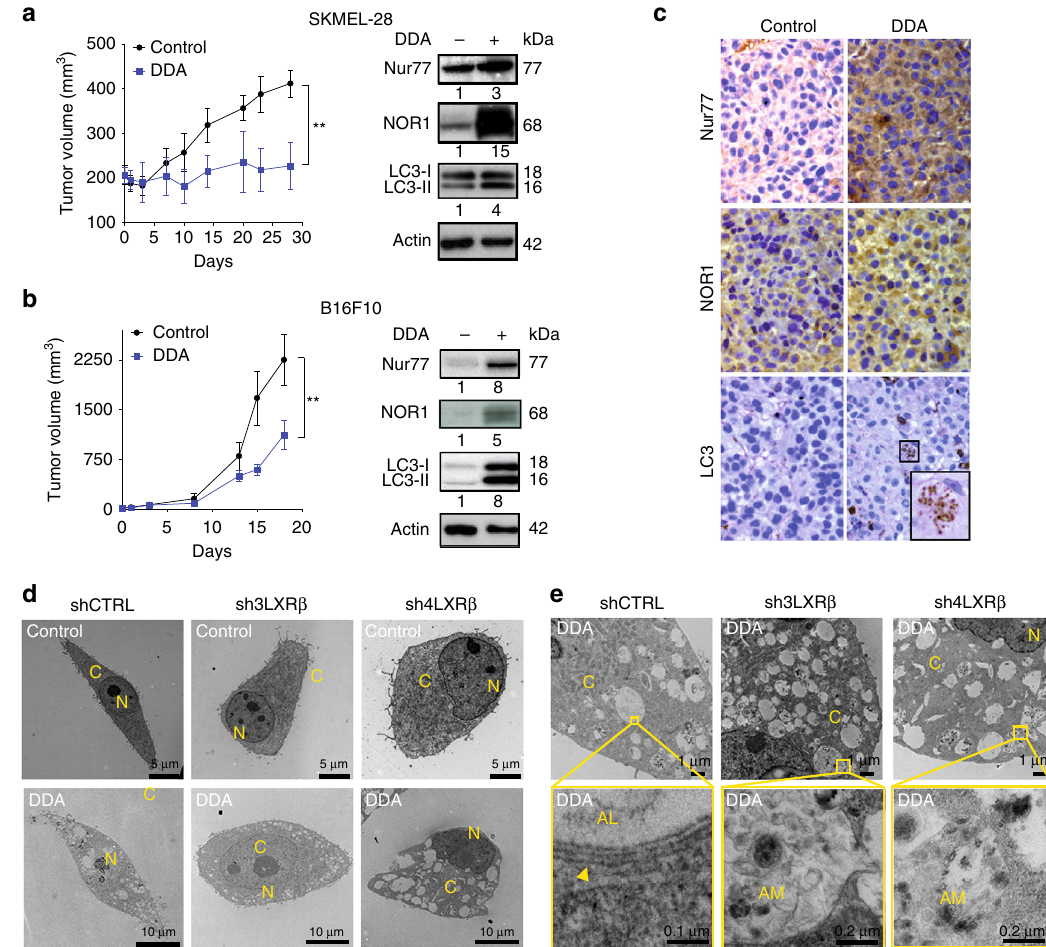
Fig. 4 DDA induces autophagy in melanoma in vivo and in vitro in an LXR β -dependent manner. a , b Mice engrafted with human SKMEL-28 or mouse B16F10 cells (10 per group) were treated with DDA (i.p. 20 mg/kg/day) or vehicle. Mean tumor volumes ± S.E.M. are shown, ** P < 0.01, analysis of variance (ANOVA). Data are representative of three independent experiments. At the end of treatments, tumors were analyzed for Nur77, NOR1 and LC3 protein expression by a , b immunoblotting or c immunohistochemistry (brown staining). c Representative immunohistochemical analysis. Magni fi cation ×40. Insert is 4× digital ampli fi cation. d , e TEM images of cells transfected with shCTRL, sh3LXR β , or sh4LXR β and treated with control vehicle or 2.5 µ M DDA for 24 h. e TEM images of cells transfected with shCTRL, sh3LXR β , or sh4LXR β and treated with 2.5 µ M DDA for 24 h. d , e N, nucleus; C, cytoplasm; AM,